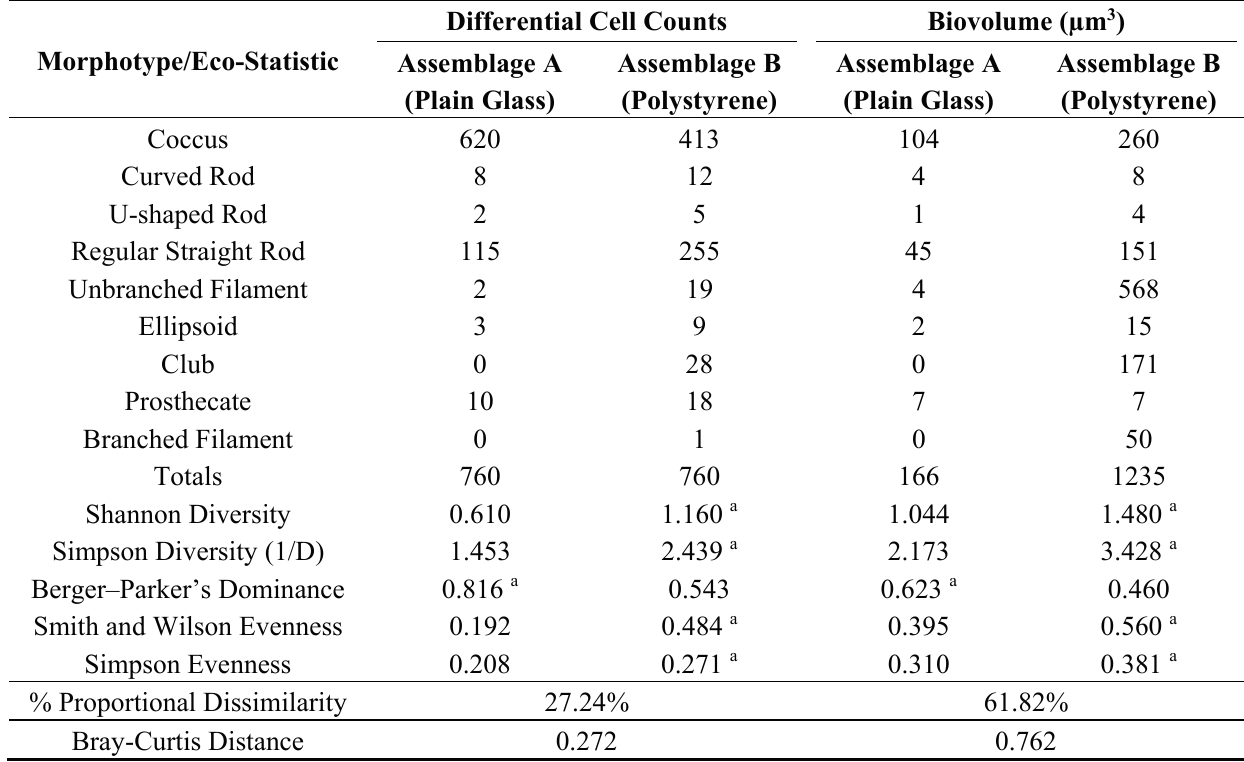
Table 1. CMEIAS (Center for Microbial Ecology Image Analysis System) analysis of morphological diversity in the river biofilm assemblages on plain glass and polystyrene using differential cell counts or cell biovolume as the metric of population